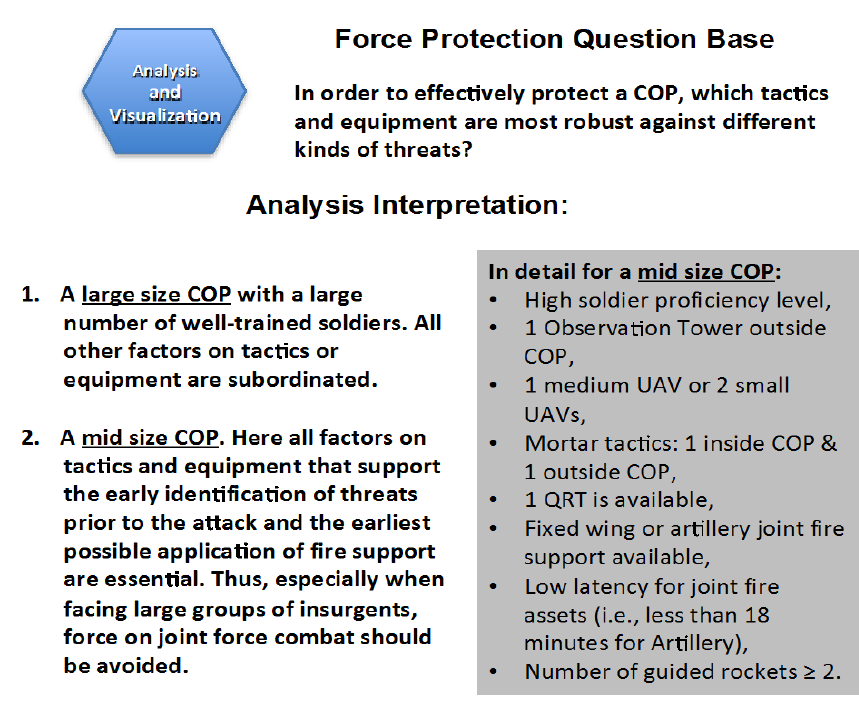
Figure 9. Result interpretation for the force protection scenario.